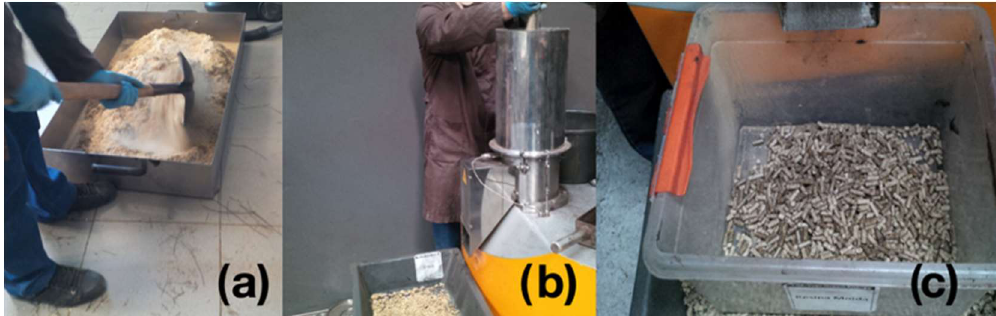
Figure 2. Pellet production process using a KAHL laboratory scale pelletizing machine with a production capacity of 25 kg / h. ( a ) The mixing process for homogenizing the product to be pelletized, mainly to ensure that the humidity is uniform; ( b ) the equipment used to produce the pellets; ( c ) the final result. The pellets were produced exclusively with Acacia dealbata biomass.